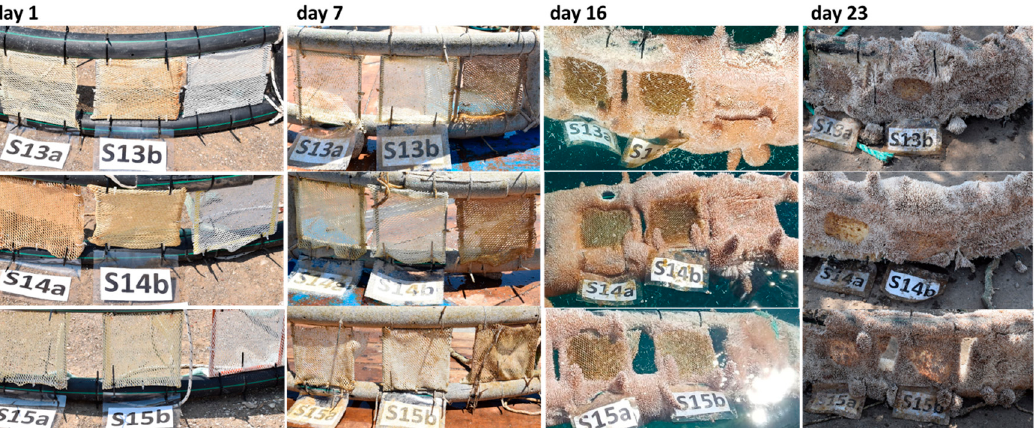
Figure 9. Coated nets with the polymeric systems P(SSAmC 16 ‐ co ‐ GMA20)/PAA (S13), P(SSAmC 16 ‐ co ‐ GMA20)/PAA/PHMG (S14) and P(SSAmC 16 ‐ co ‐ GMA20)/P(VBCTMAM ‐ co ‐ AA20) (S15), after immersion in the sea for various time periods. Every triplet of nets consists of an uncoated net (to the right) for comparison.